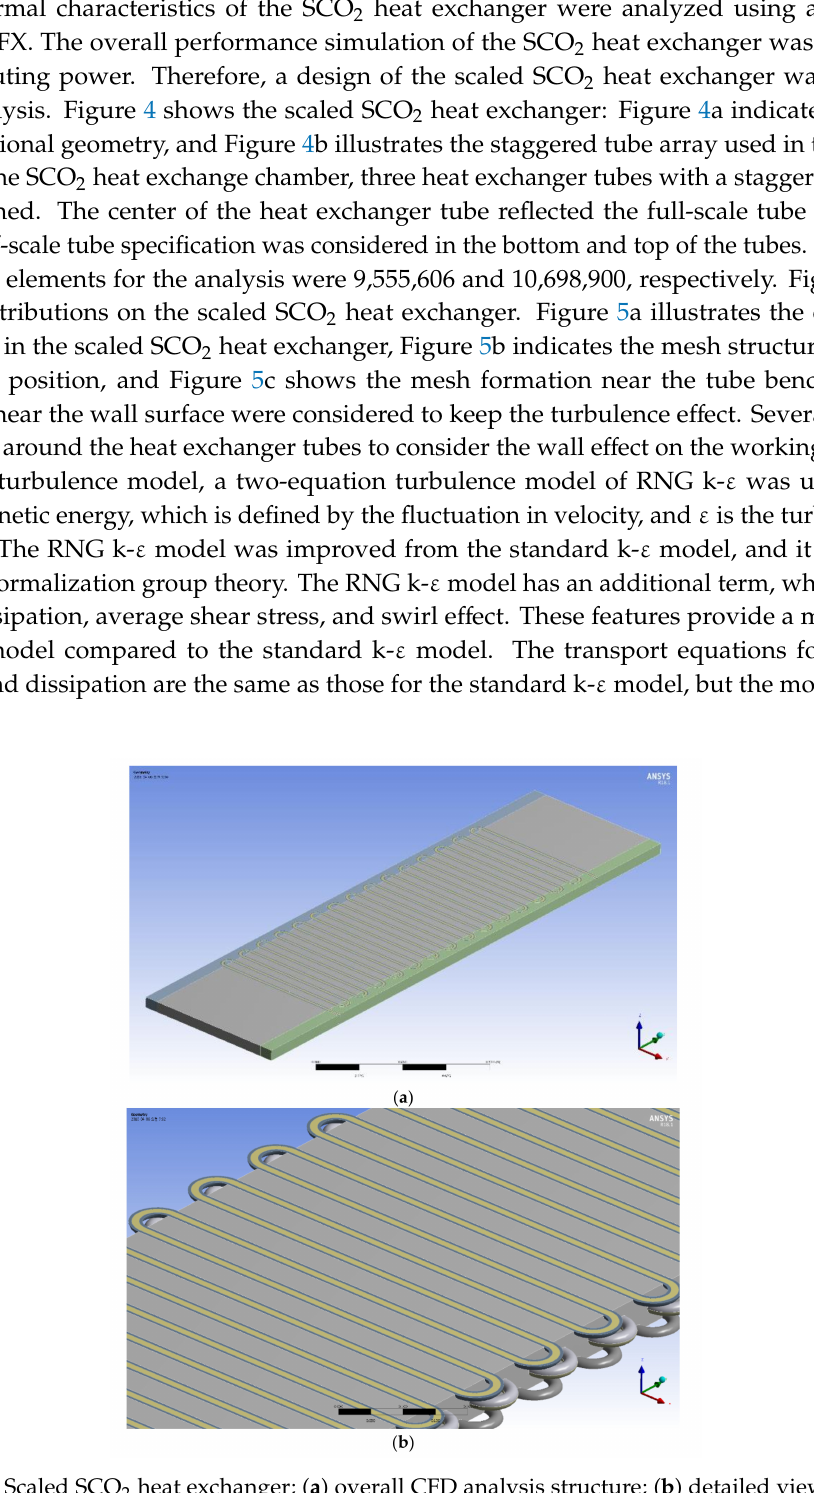
Figure 4. Scaled SCO 2 heat exchanger; ( a ) overall CFD analysis structure; ( b ) detailed view around heat exchanger